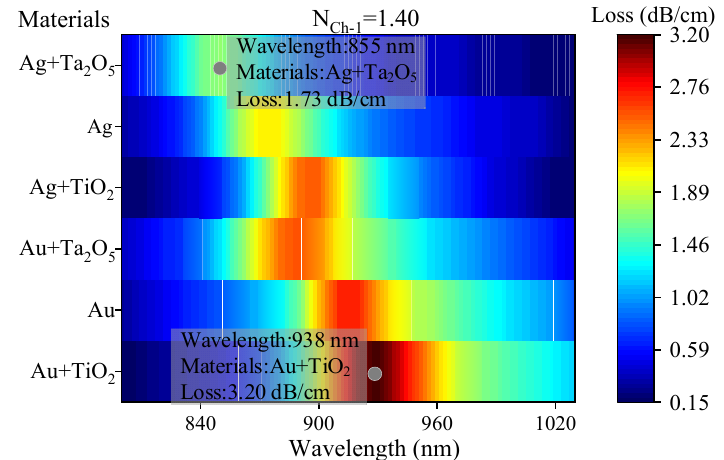
Figure 4. Selection and analysis of detection plane materials.